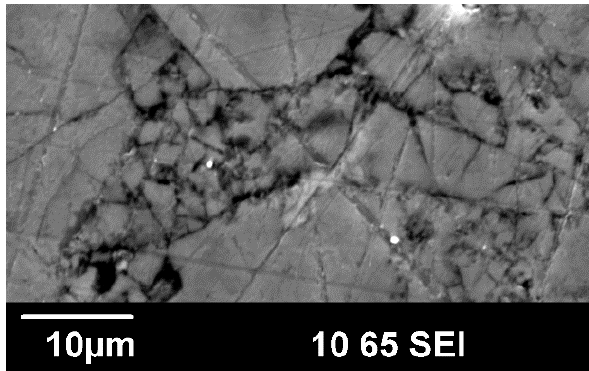
positions (purple ticks) from Rietveld refinement.